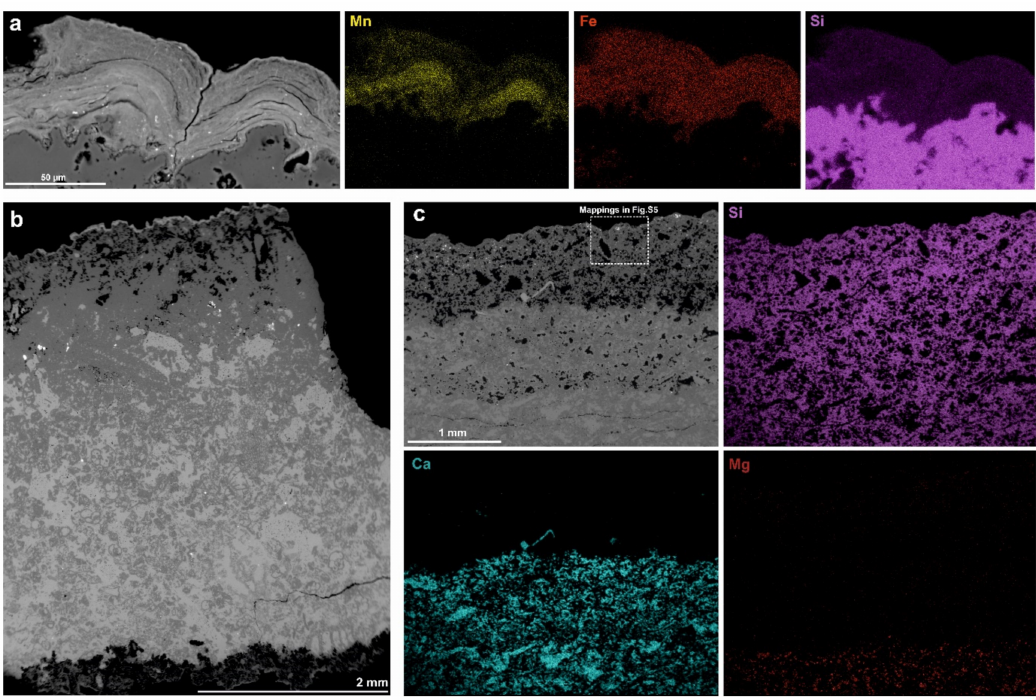
Figure 7. SEM–EDX analyses on petrographic thin sections: ( a ) SEM image in backscattered electron mode and EDX elemental mapping (Mn, Fe and Si) of the black varnish; ( b ) SEM image in backscat- tered electron mode of the thin section of sample AV1 showing the lack of Ca in the upper part of the sample and a heavily weathered area at the bottom; ( c ) SEM image in backscattered electron mode with EDX elemental mapping (Si, Ca and Mg) of the weathered area of sample EZ3 (additional elemental mappings of the area in the dashed box in Supplementary Figure